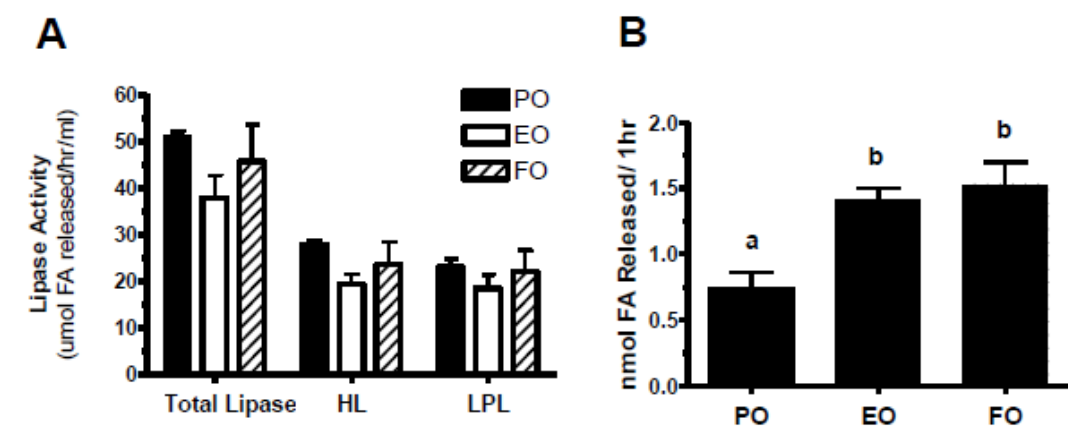
Figure 6. Post-heparin plasma lipase activity. ( A ) Total lipase, hepatic lipase (HL), and lipoprotein lipase (LPL) activities in plasma of mice after 28 days of PO, EO, or FO diets ( n = 4, n = 6, n = 4, respectively). After a 4 h fast, mice were injected with 100 units/kg (180 mg/kg) heparin sodium salt (Sigma) dissolved in saline. 10 min post-injection, blood was collected and plasma separated as described previously. Triolein (Sigma) was used as a substrate. See Materials and Methods for details on substrate preparation. Post-heparin plasma was combined with the substrate and apoCII (Sigma) as a co-activator. HL activity was assayed by salt inhibition of LPL and LPL activity was calculated as total lipase activity minus HL activity. ( B ) VLDL lipolysis by purified LPL. 2 µg of VLDL TG from each diet group (PO, n = 7; EO, n = 11; FO, n = 3) were incubated with 25 ng of LPL (Sigma) for 1 h at 37 °C. Total NEFA released were measured by colorimetric analysis using a NEFA assay (Wako). The bars represent mean ± S.E.M. Values with different letters are significantly different ( p <